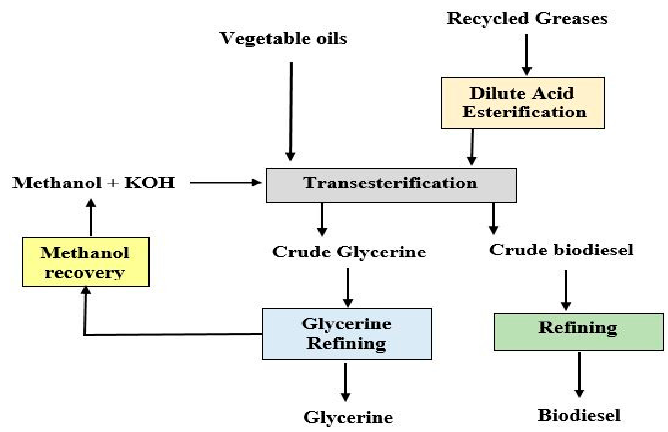
Figure 2. An overview of a standard biodiesel production process - Biodiesel and glycerol are the two main products.